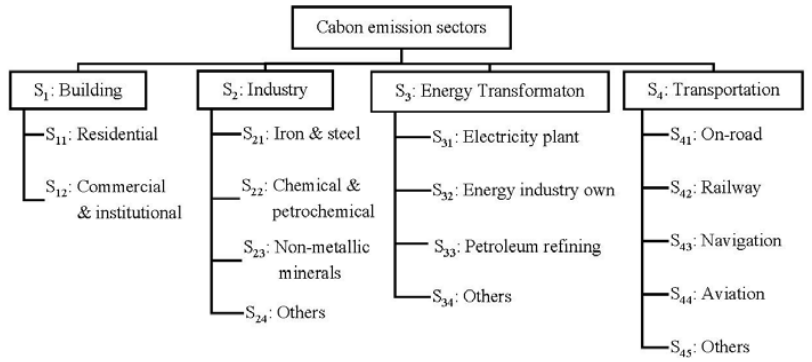
Figure 3. Classification framework of emission sectors.